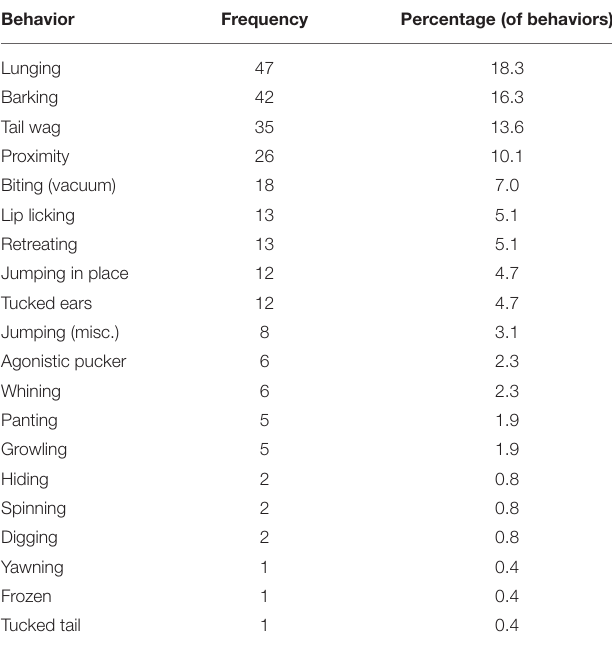
TABLE 8 | Stress-related dog behaviors ( n = 257) recorded in the YouTube video compilation